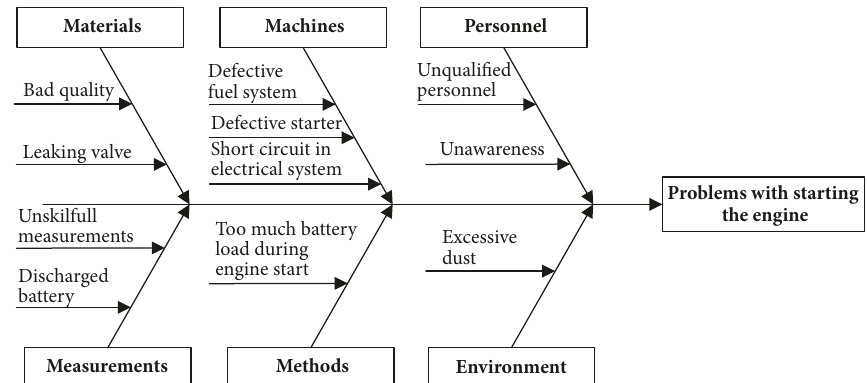
Figure 4: Ishikawa diagram for the electrical system.